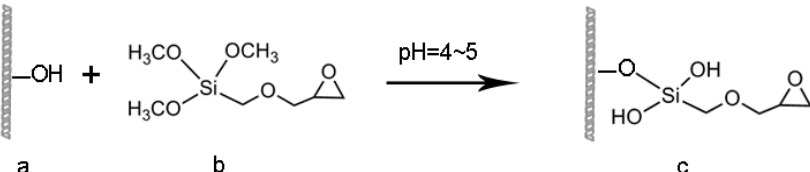
Scheme 1. Schematic illustration of NCC modified by silane coupling agent: ( a ) NCC; ( b ) KH-560; ( c ) MNCC.